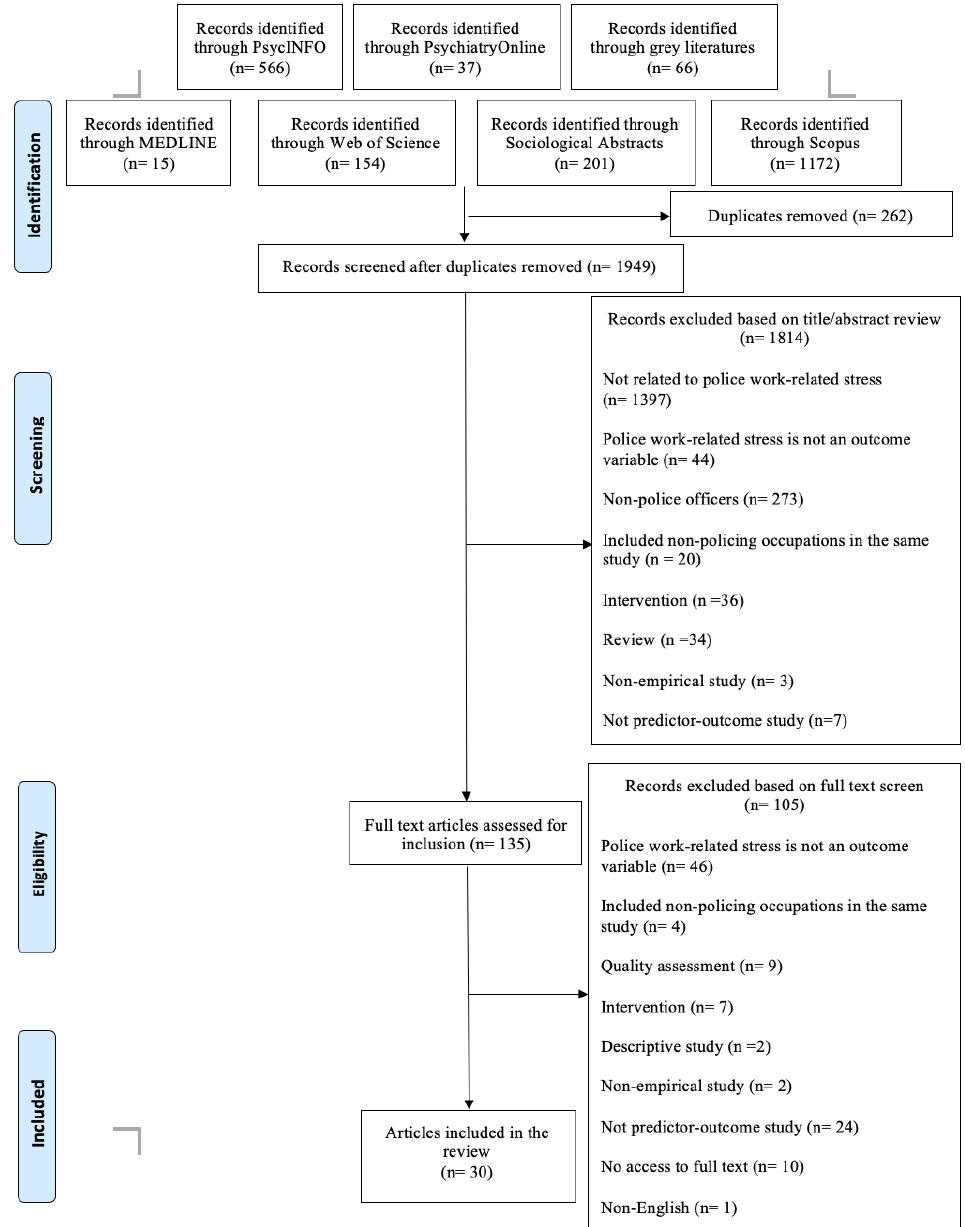
Figure 1. Flow diagram of the search process.